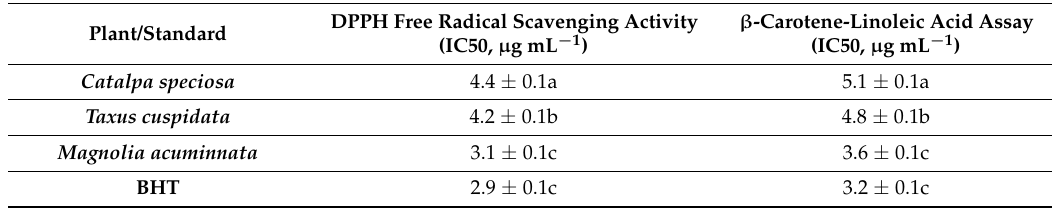
Diphenyl picryl hydrazyl (DPPH) and β -carotene-linoleic acid of Catalpa speciosa , Taxus cuspidata , Magnolia acuminnata outer bark